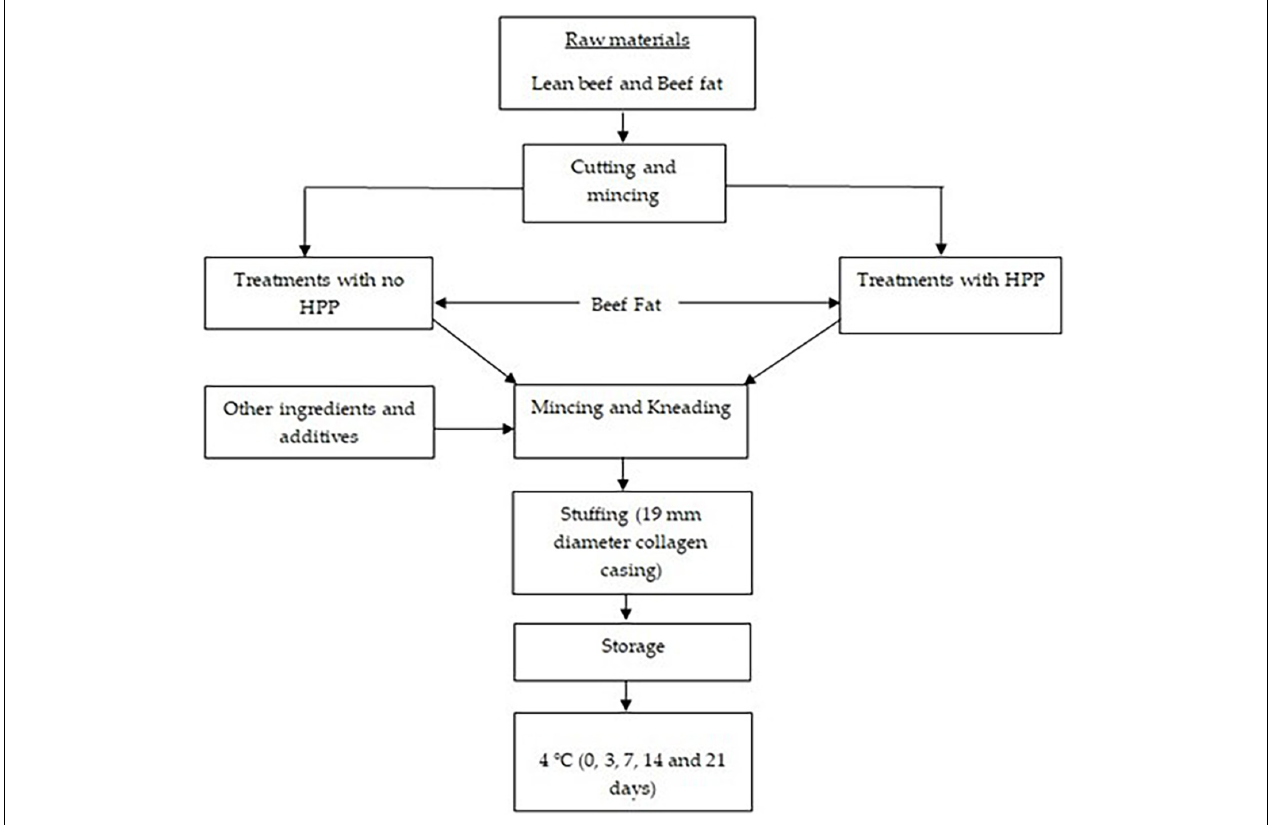
FIGURE 1 | Flow diagram of the manufacture and storage of beef sausage under study (treatments with HPP and treatment with no HPP).